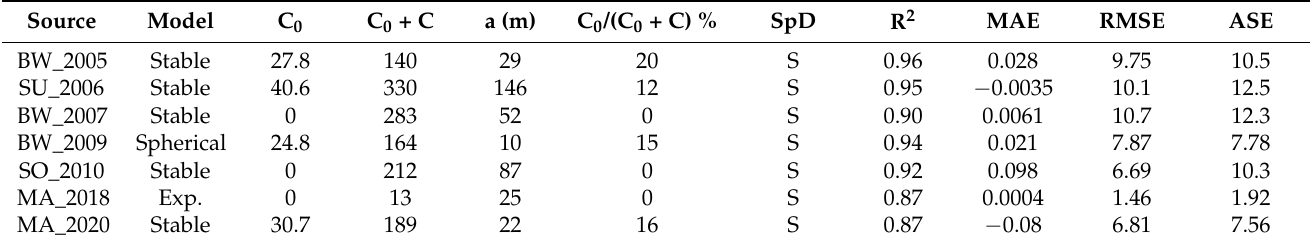
Table 5. Semi-variogram parameters of standardized crop yields over seven